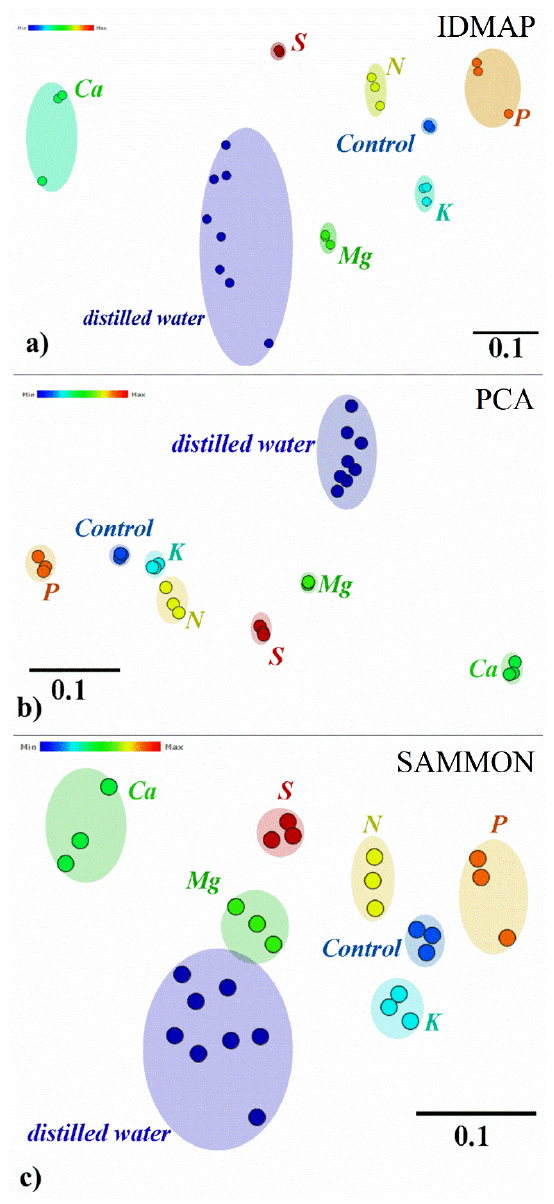
Figure 4. ( a ) IDMAP; ( b ) PCA and ( c ) SAMMON plots of capacitance data using the whole spectra for the detection of soil samples enriched with N, P, K, Ca, Mg, and S. The black scale bar at the bottom is equivalent to 0.1 in Euclidean distance and can be used to measure the distance between the clusters formed.